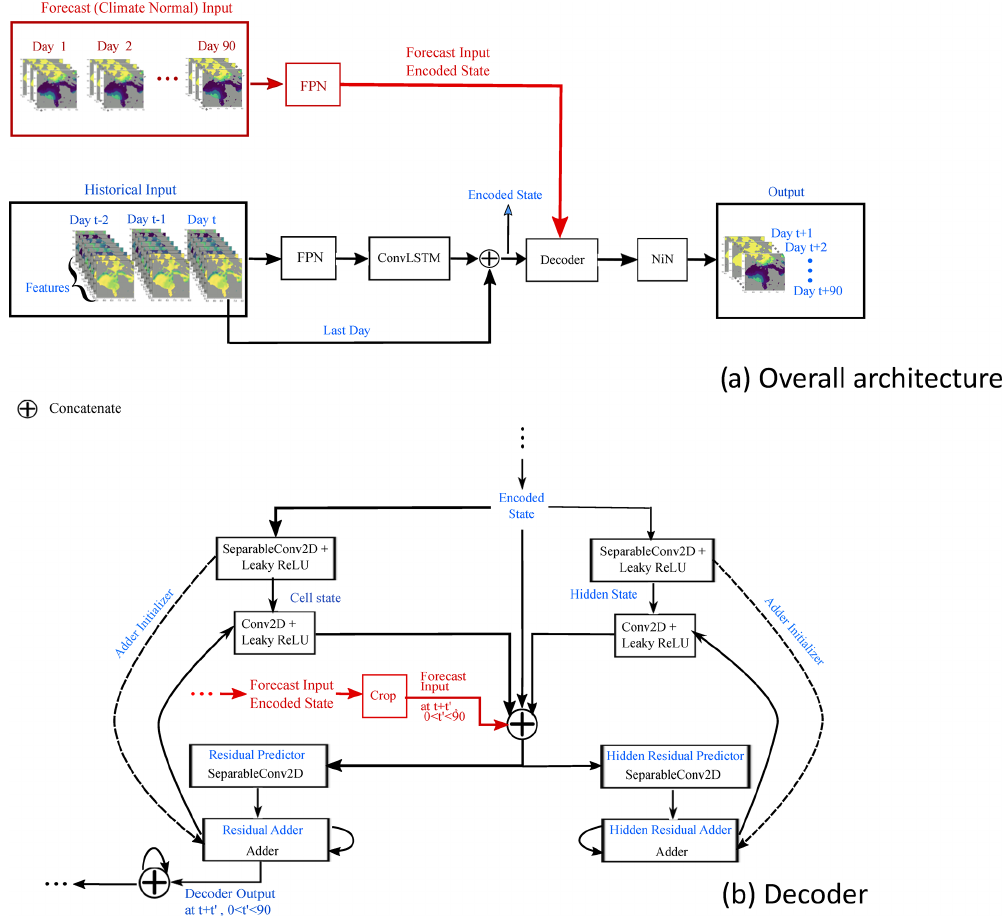
Figure 2. (a) Overall network architecture and (b) custom decoder. The black portion in panel (a) refers to the Basic model, while the red portion in panel (a) refers to the additional components required for the Augmented model. The dashed arrows show a process carried out only once (the initialization of the adder). FPN: feature pyramid network, ConvLSTM: convolutional long short-term memory network, NiN: network in network module, ReLU: rectified linear